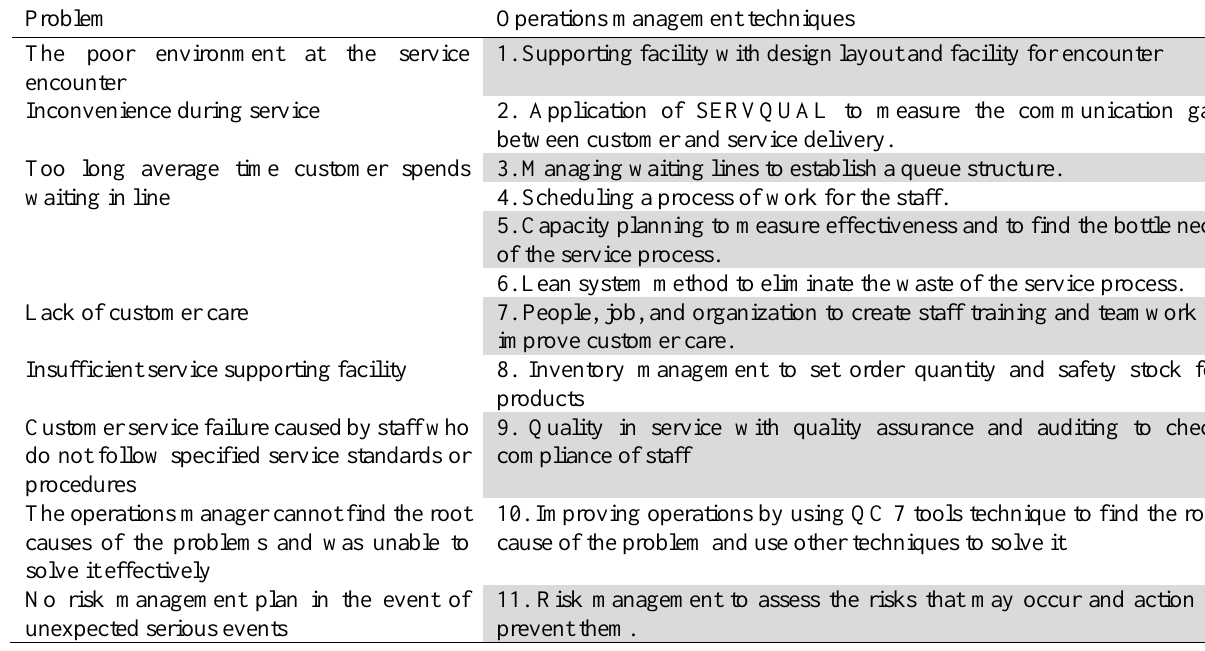
Operations management knowledge to solve the identified operations